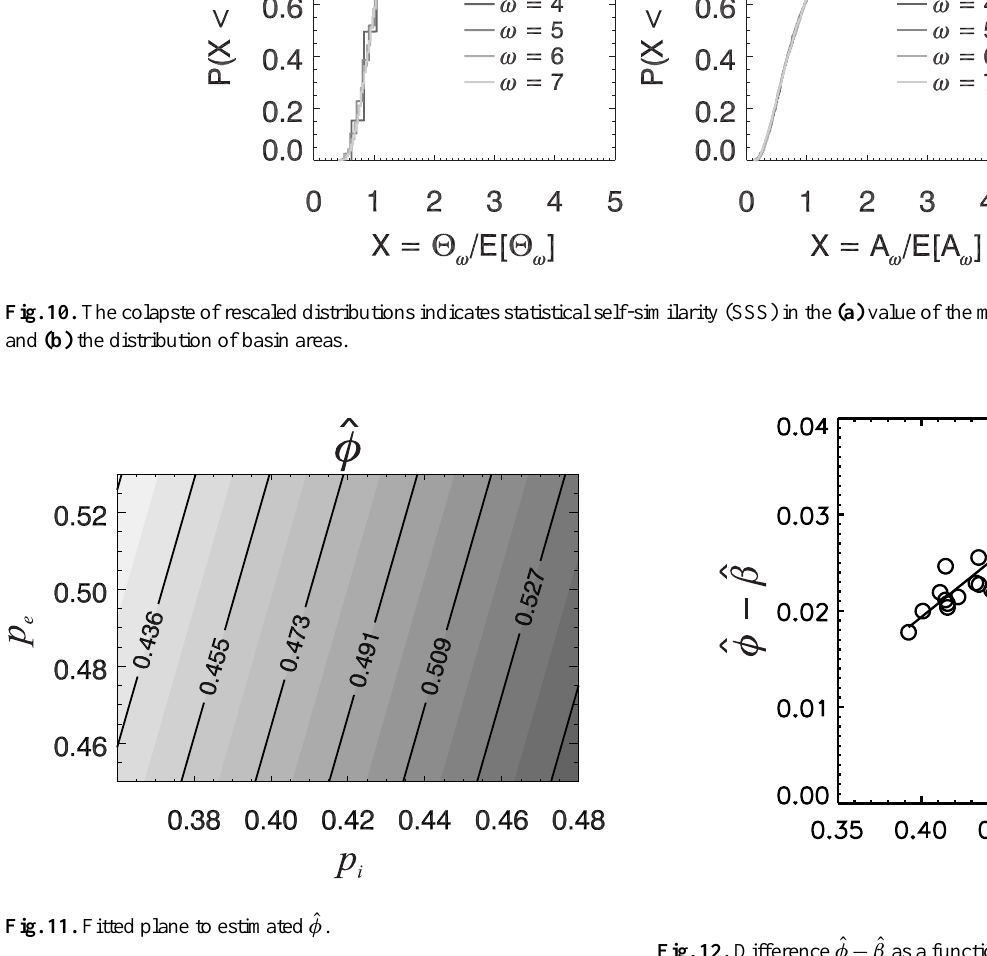
Fig. 12. Difference ˆ φ − ˆ β as a function of ˆ β